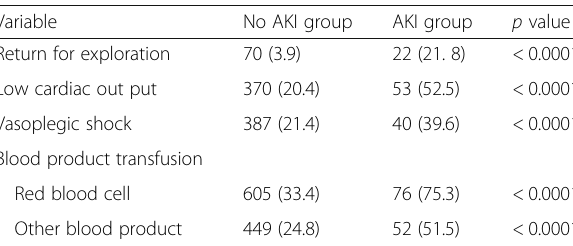
AKI group and No AKI group